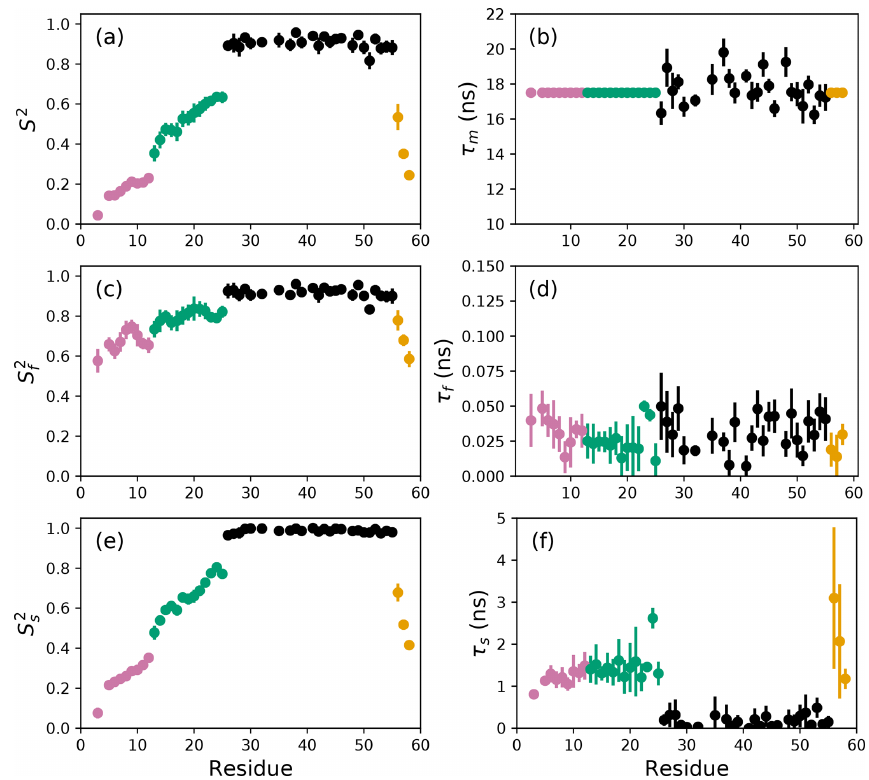
Figure 4. Smoothed model-free parameters from bootstrap aggregation to determined smoothed parameter estimates and uncertainties. Values of S 2 , τ m , S 2 , τ f , S 2 s , and τ s are plotted vs. residue number. Regions of the protein are colored as basic region 1 (residues 3–12) f (reddish-purple), basic region 2 (residues 13–25) (green), coiled-coil (residues 26–55) (black), and disordered C-terminus (residues 56–58) (orange) (Gill et al., 2016).